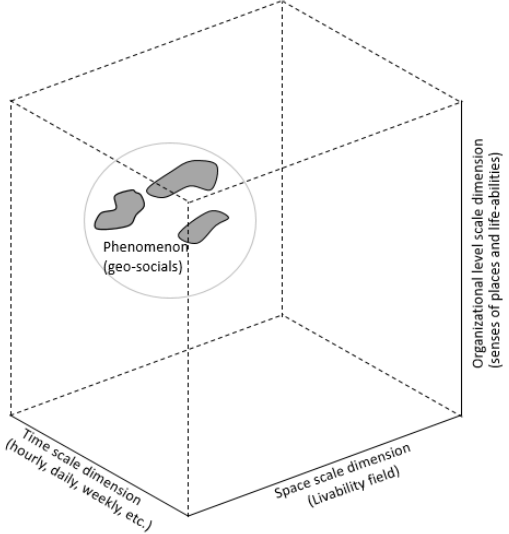
Figure 4. The scale dimensions cube for the conceptual urban quality space – place framework.